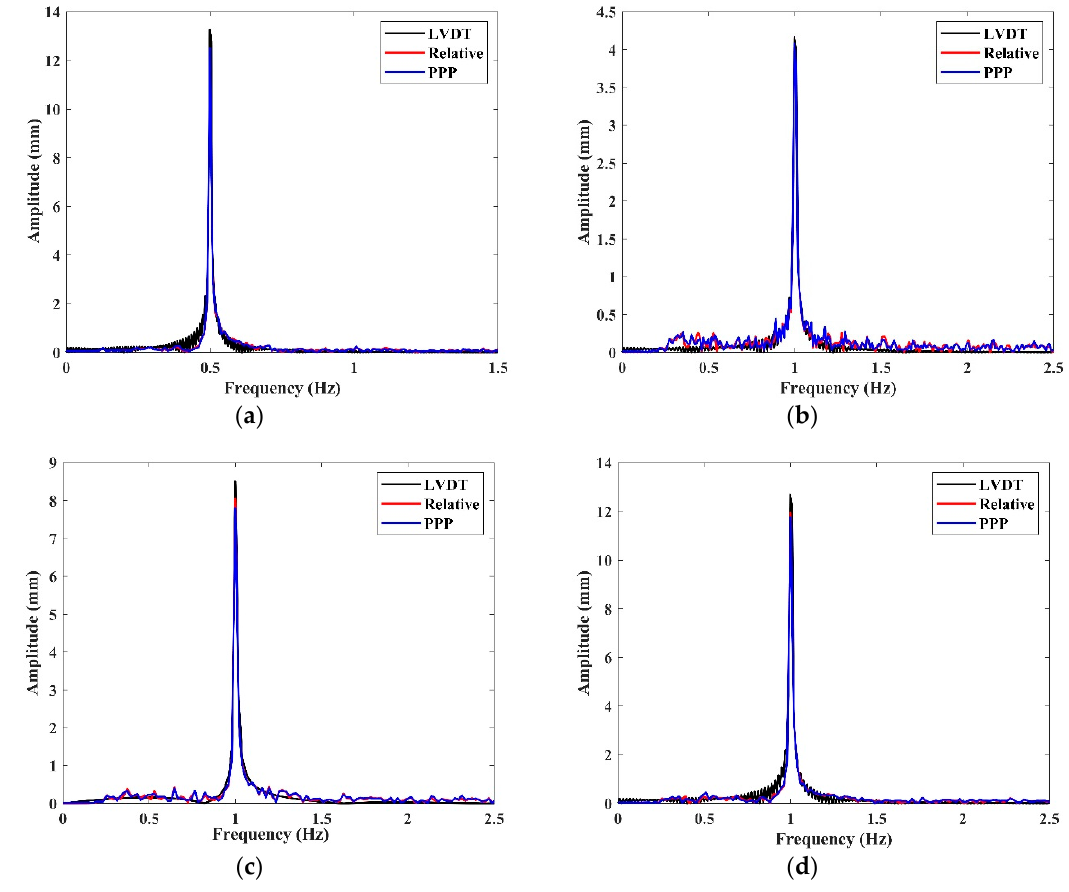
Figure 13. Spectrum diagram of the four events: ( a ) event 1, ( b ) event 2, ( c ) event 3, and ( d ) event 4.